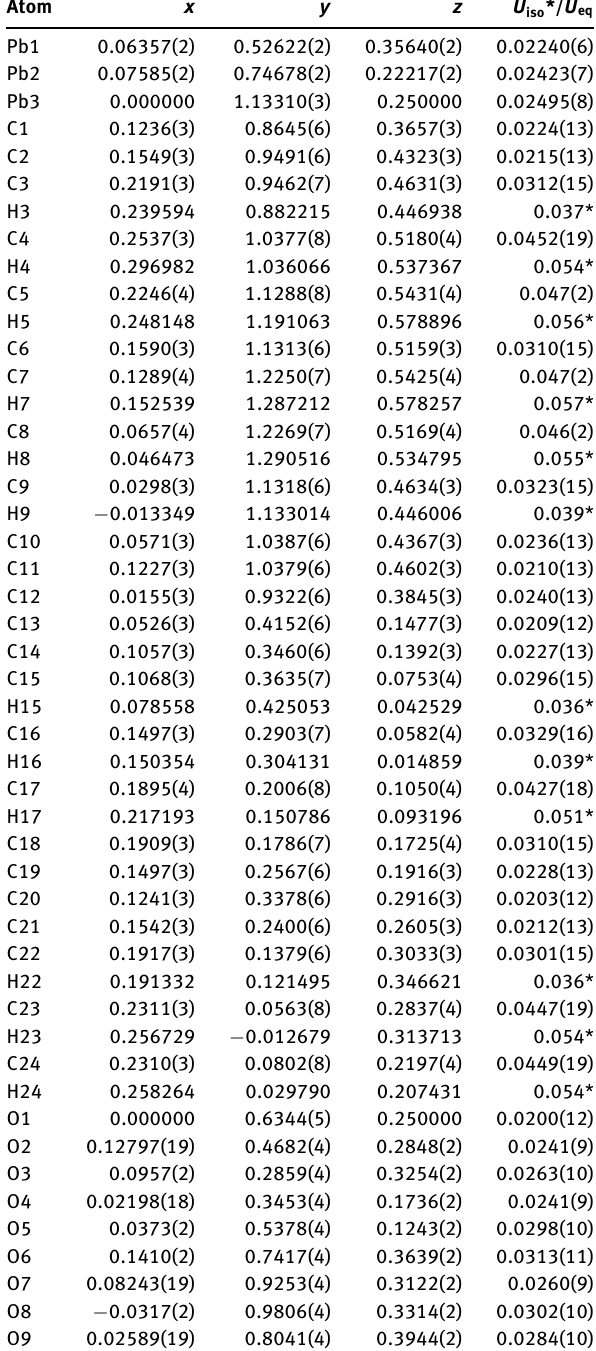
Table 2: Fractional atomic coordinates and isotropic or equivalent isotropic displacement parameters (Å 2